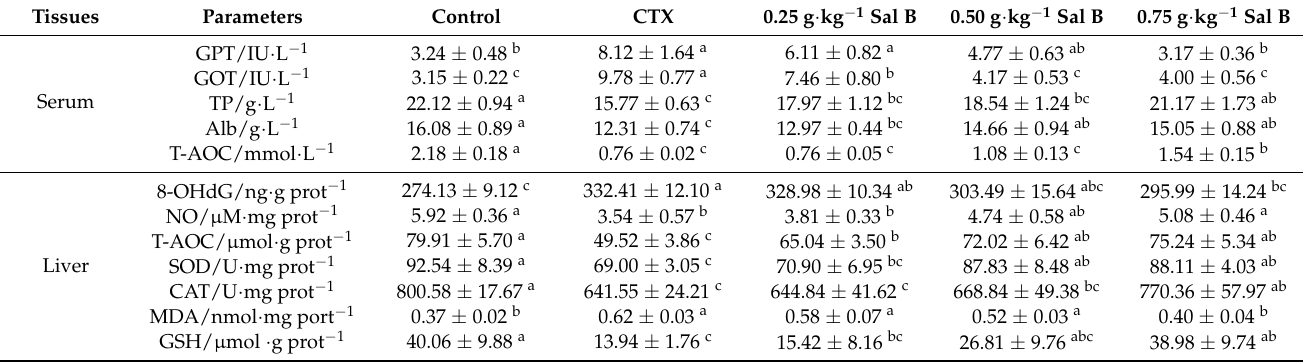
Table 4. Effects of Sal B on biochemical indexes in serum and liver samples of Nile